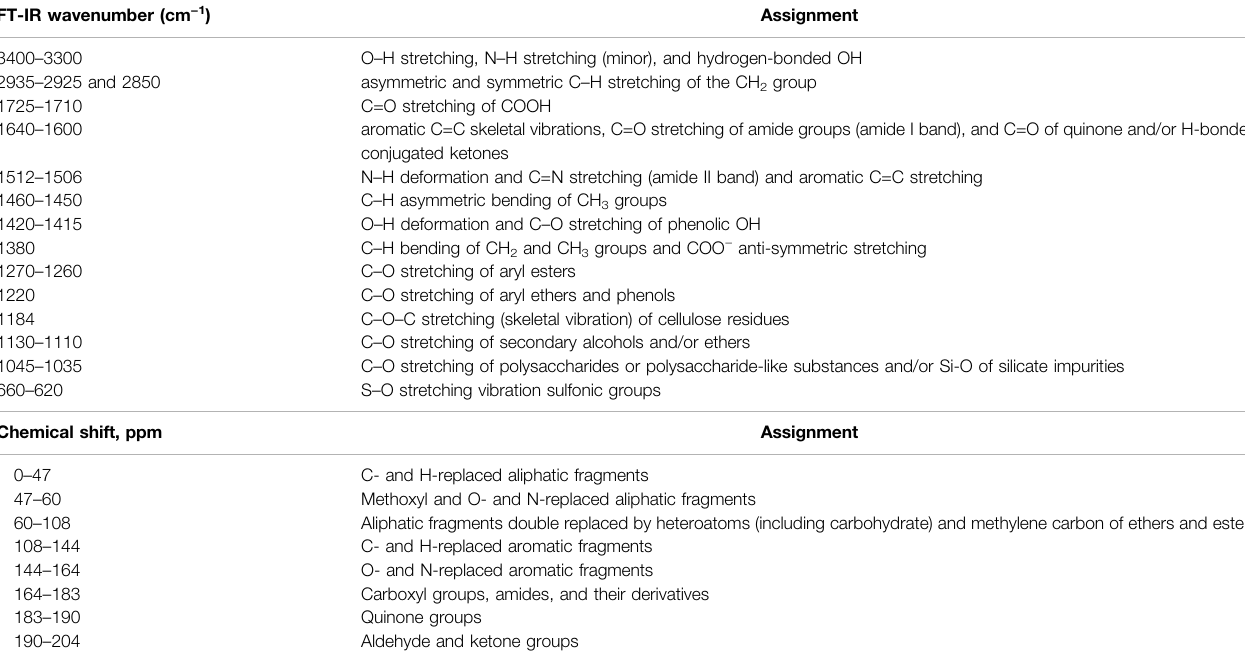
TABLE1| MajorFouriertransforminfraredspectroscopy(FT-IR)absorptionbandsandchemicalshiftsofC 13 atomsinmolecularfragmentsofhumicsubstances(Enevetal., 2014; Chukov et al.,